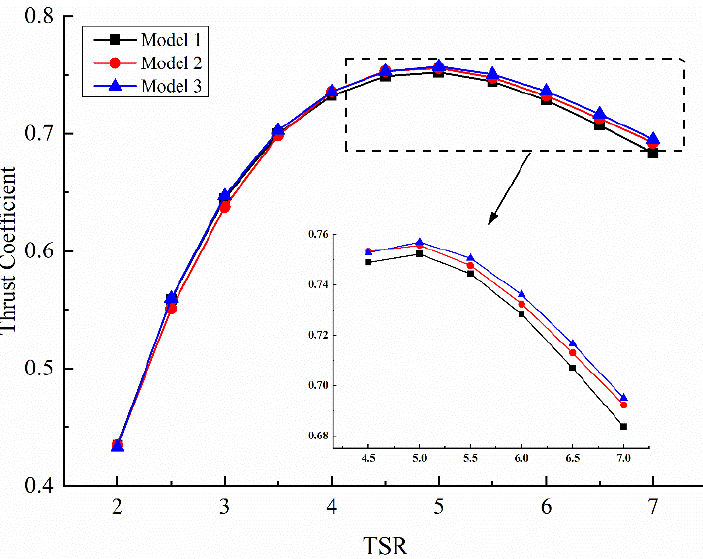
Figure 12. Comparison of trust coefficients of different models.